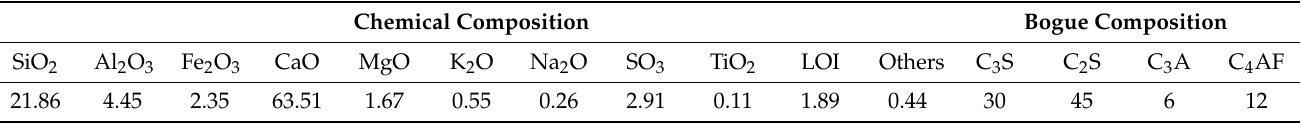
Table 2. Chemical and Bogue composition of of OPC (by weight, wt%). Chemical Composition Bogue Composition SiO